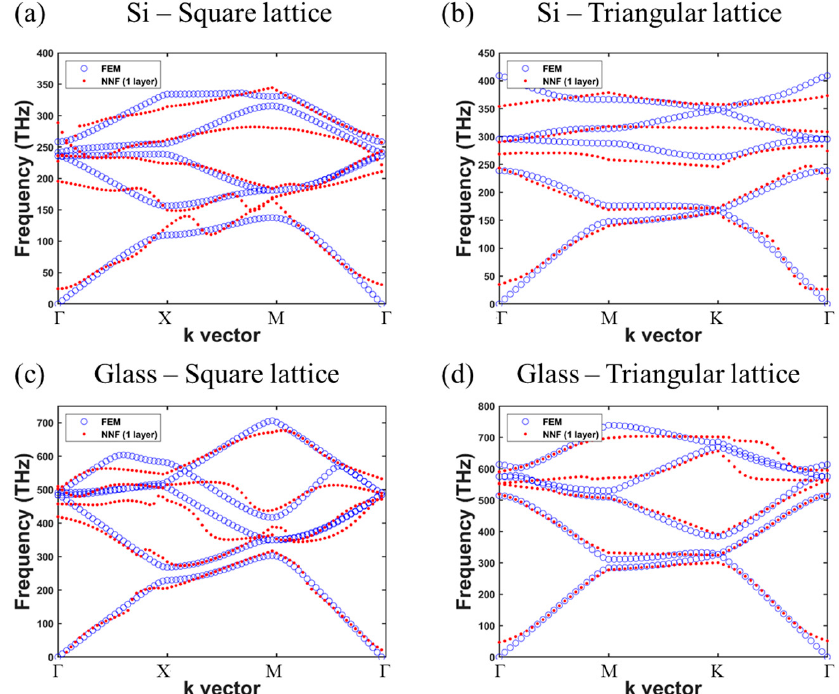
Figure 4. FEM-calculated (blue circles) and predicted (red dots) band structures of PCs made of Si in ( a ) square lattices and ( b ) triangular lattices and glass in ( c ) square lattices and ( d ) triangular lattices with r/a = 0.45 and 10 neurons in the hidden layer.